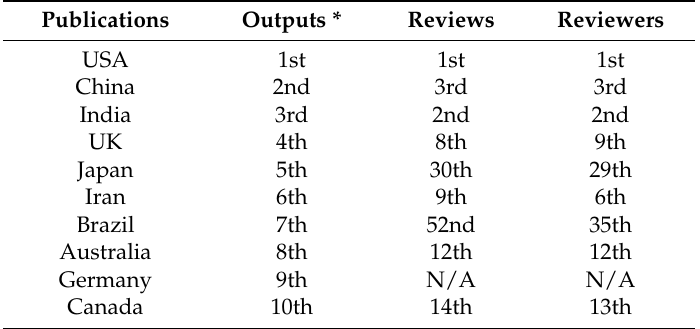
Figure 2. ( a ) Global distribution of the 250-strong sample of top reviewers. ( b ) Global distribution of the 46,079-strong sample of ‘top’ reviews. Table 1. Ranking of countries per research outputs and corresponding match in terms of reviews and reviewers in the sample analysed. * Research outputs ranking has been retrieved from Reference [12].